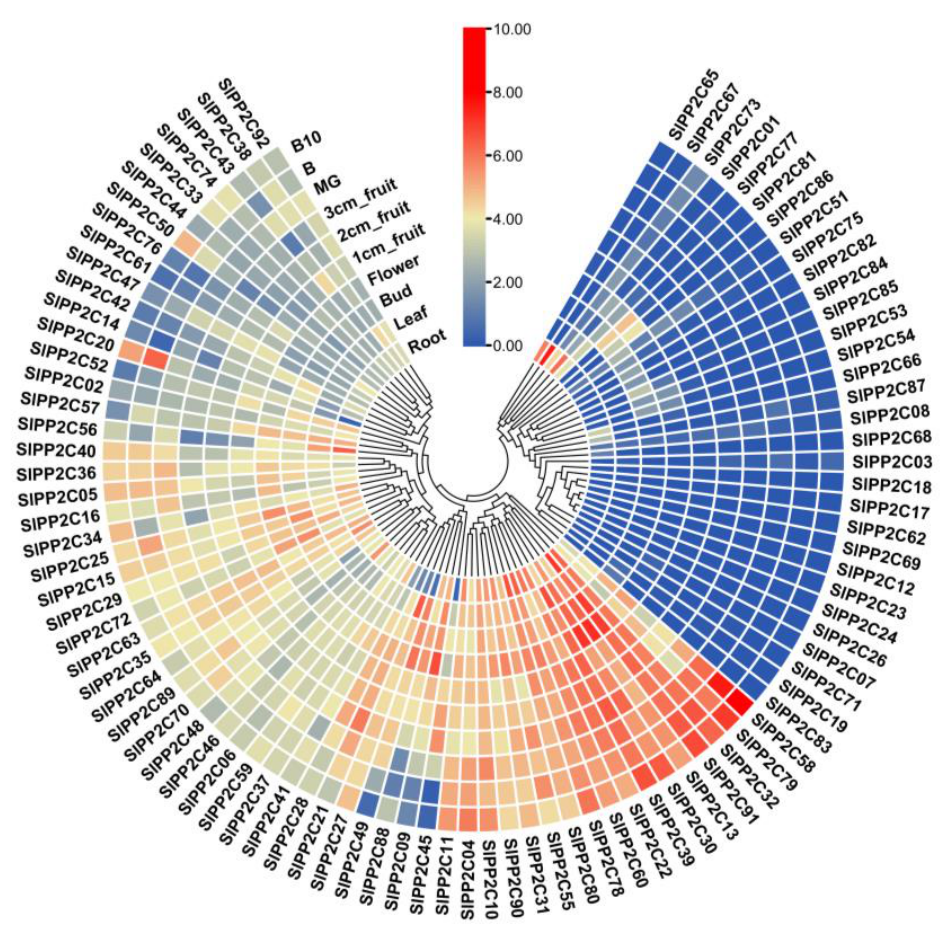
Figure 6. Heat map of the expression patterns of SlPP2Cs in 10 tissues/stages. Data of 10 tissues in the TFGD database were collected to reconstruct the expression pattern of SlPP2C genes. Heat map is presented in blue/yellow/red colors that indicate low/medium/high expression, respectively. The result was processed through cluster analysis.